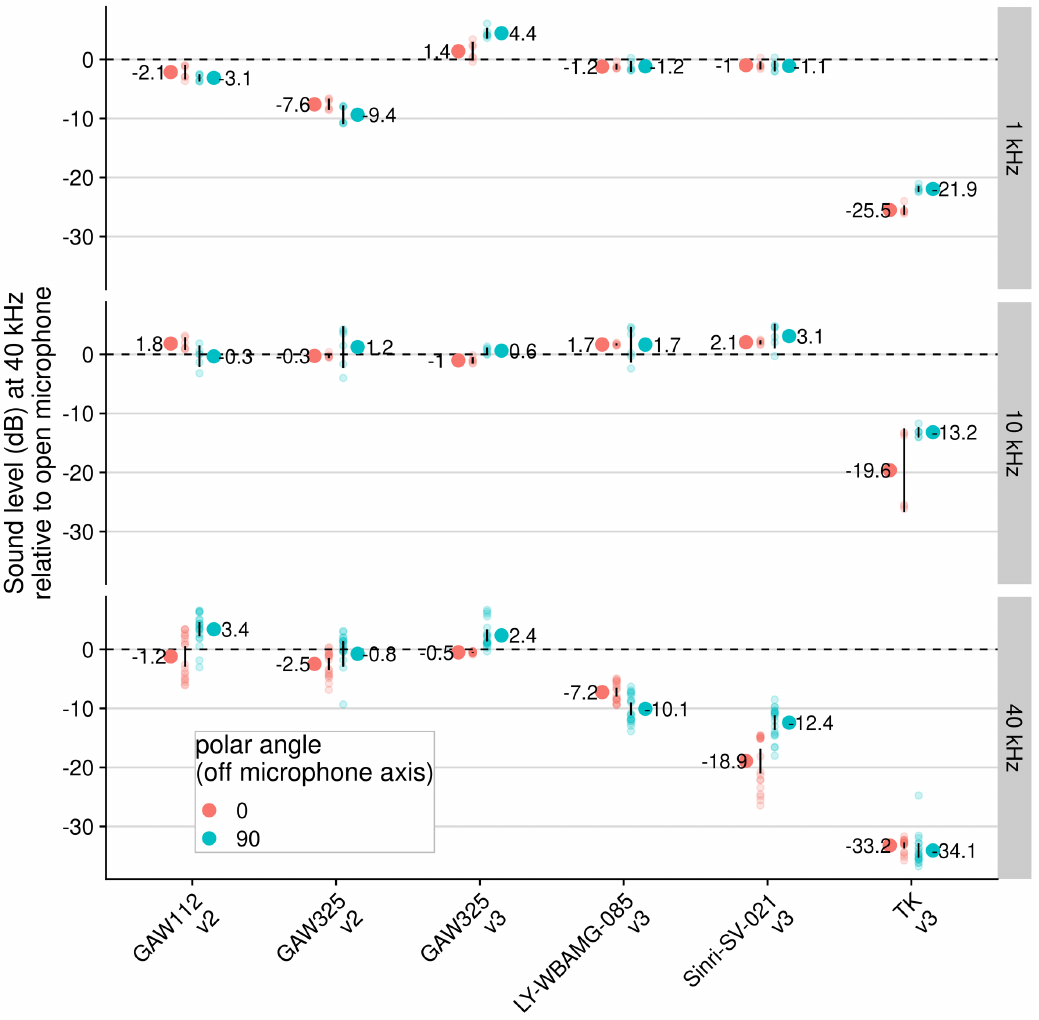
Figure 3. Sound transmission loss caused by five different acoustic vents, in front and to the side of the microphone axis, shown with 95% confidence intervals. The GAW112 offers IP4X to IP6X protection, the LY-WBAMG-085 and SV-021 offer IP67 protection, te “TK” vent has a non-rated protection level, and the GAW325 vent offers IP67 to IP68 protection (ratings depend on the